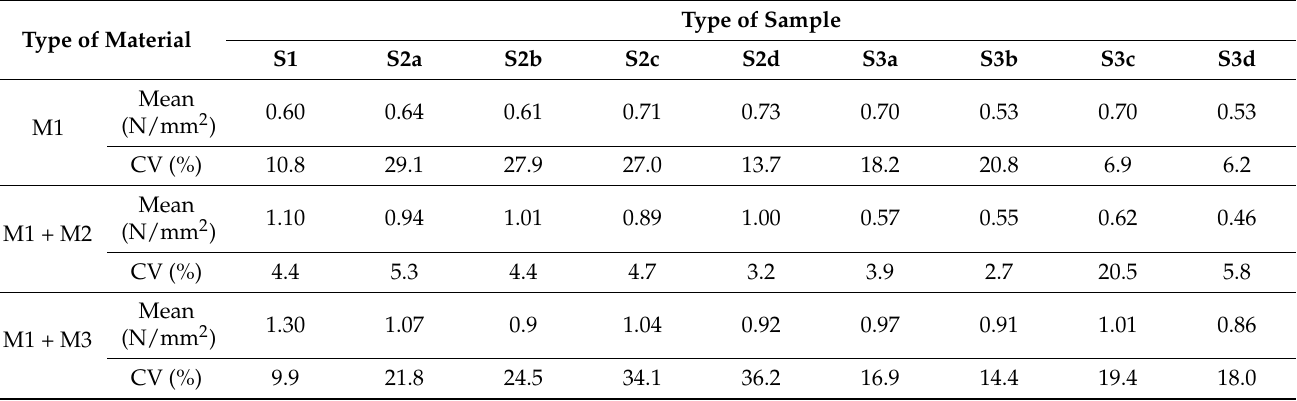
Table 2. Poisson’s ratio mean values and coefficient of variation.